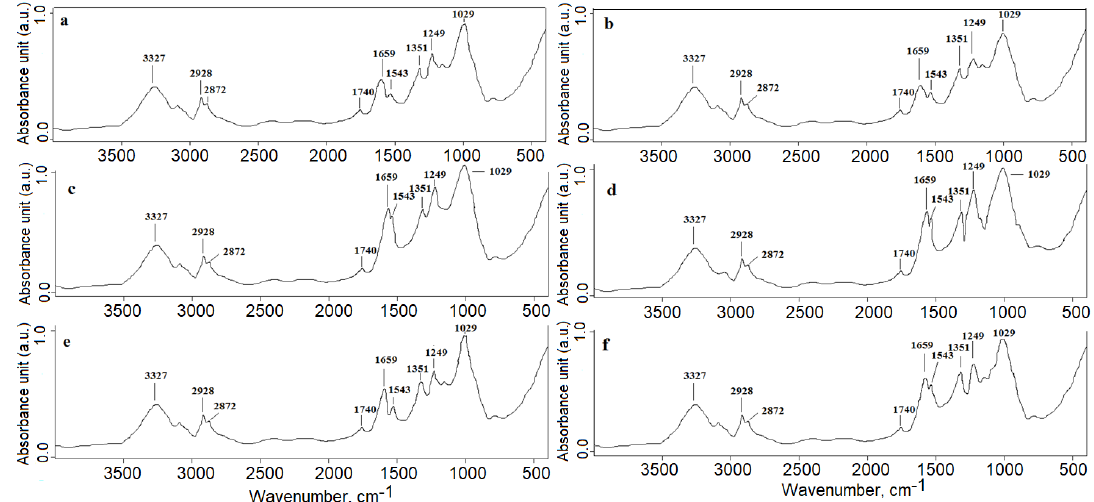
Figure 3. Fourier-transform infrared (FTIR) spectra of microgreens: ( a ) control, ( b ) without water, ( c ) with 0.5% of algae, ( d ) with 1% of algae, ( e ) with 5% of algae, and ( f ) with 10% of algae.